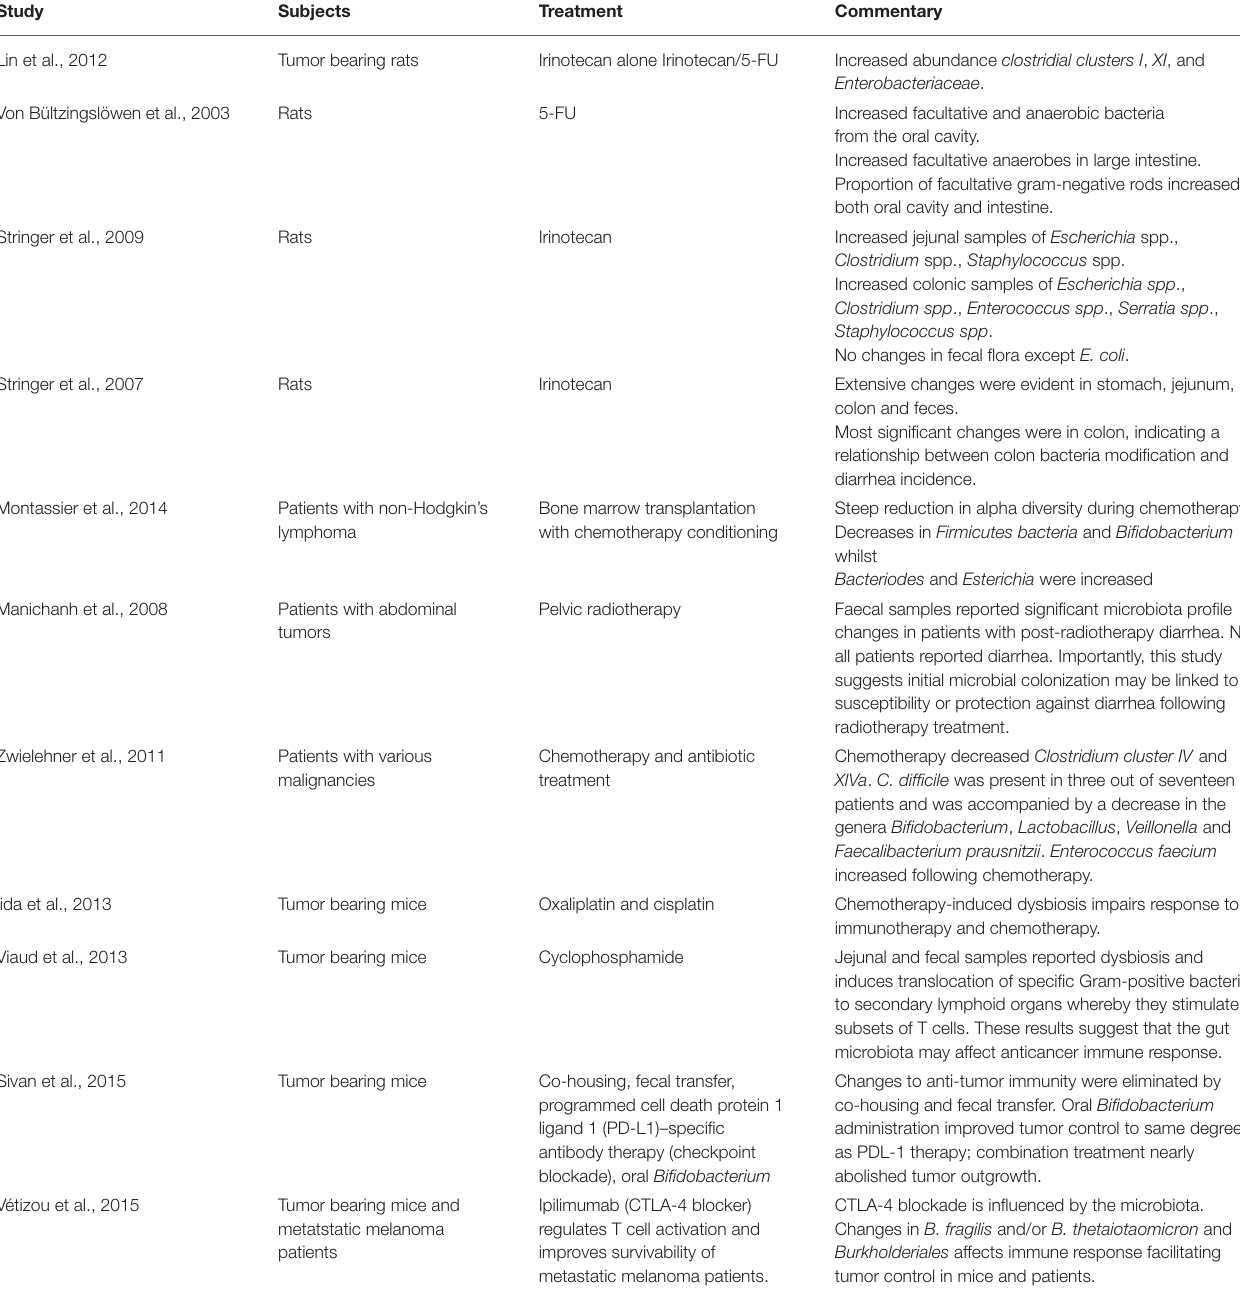
TABLE 1 | Summary of key papers highlighting chemotherapy-microbiota-immune